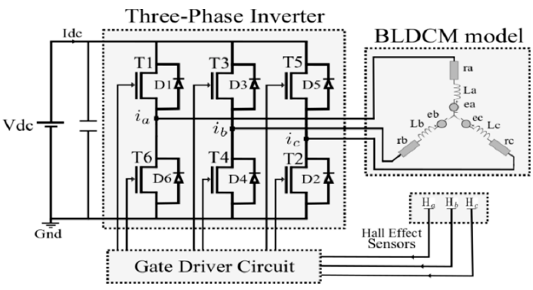
Figure 1. Brushless DC motor equivalent circuit with its inverter driver.